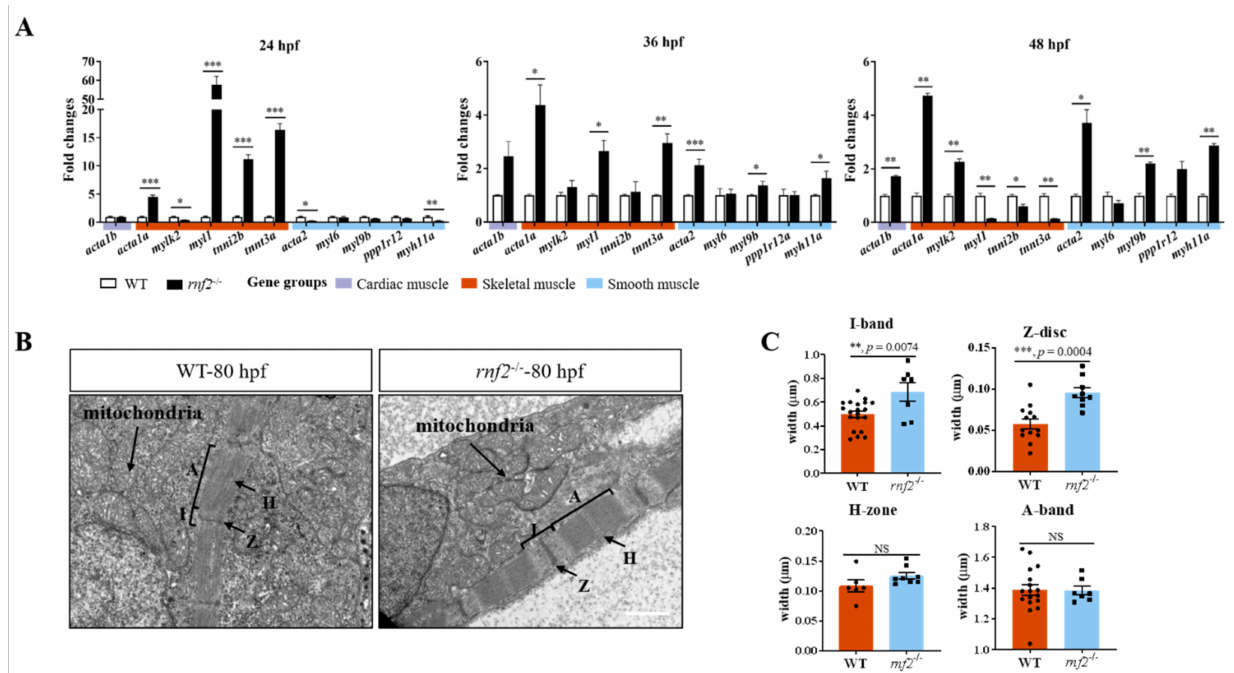
Figure 5. Rnf2 deficiency disorganized sarcomere assembly in zebrafish hearts. ( A ) Real-time PCR tested the expression of skeletal and smooth muscle genes at 36 hpf (left) and 48 hpf (right). The fold changes of relative mRNA levels are presented as mean ± SEM. The expression in wild-types was normalized to 1. The experiment was repeated on three separate occasions. n = 159, 111, and 161 for rnf2 − / − group at 24 hpf, 36 hpf, and 48 hpf, respectively; n = 145, 113, and 164 for WT group at 24 hpf, 36 hpf, and 48 hpf, respectively. ( B ) Cardiac TEM revealed the sarcomere of cardiac muscle was abnormal in rnf2 − / − hearts. A, A-band; I, I-band; H, H-zone; Z, Z-disc. Scale bar: 1.0 µ m. n = 3. ( C ) Bar graph showing the width of A-band, I-band, Z-disc, and H-zone in wild-type and rnf2 − / − cardiac sarcomeres. *, p < 0.05; **, p < 0.01; ***, p < 0.001; NS, no